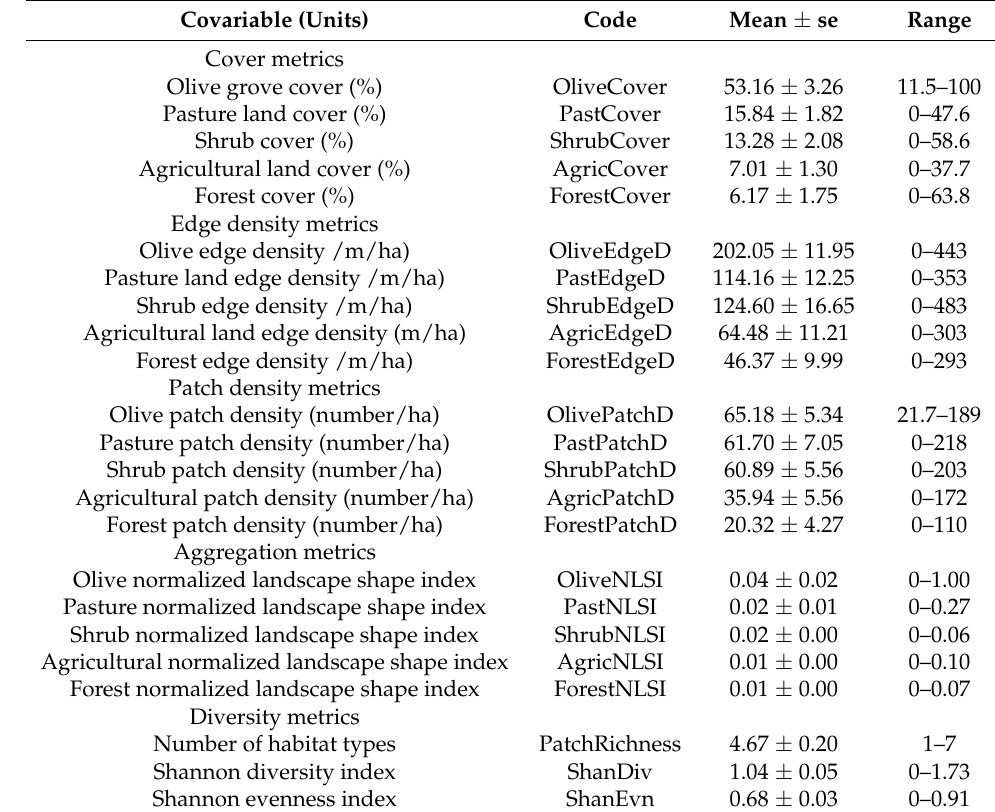
Table 3. Summary of descriptive statistics of landscape covariables of small mammal occupancy in 51 olive farms in NE